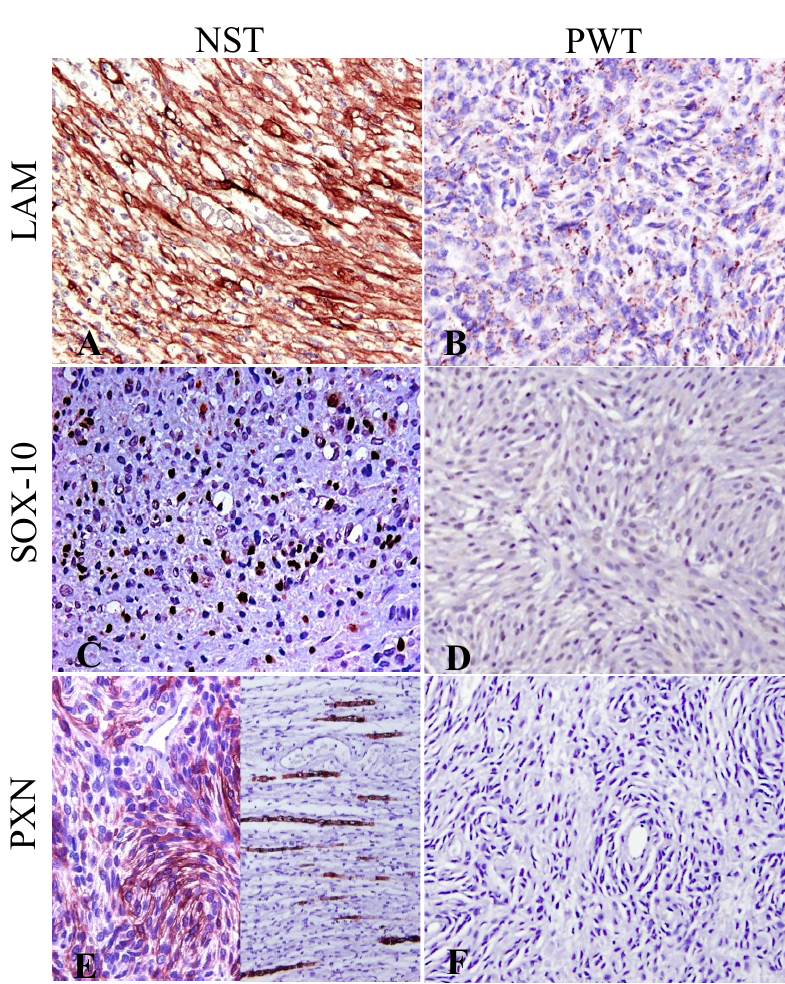
Figure 4. Discriminatory IHC panel between NST and PWT. The selected PNS panel including laminin (LAM), Sox-10 and periaxin-1 (PXN) was compared between NST and PWT. Laminin was detected in all tumors but the LAM immunolabeling pattern of PWT was different than in NST ( A , B ). NST retained Sox-10 and PXN immunoreactivity, whereas PWT did not ( C , D ). Note that PXN immunoreactivity can be observed in the cytoplasm of neoplastic cells ( E , left) and/or in nerve sheaths retained within the tumor ( E , right) in NST, but no PXN was detected in PWT ( E , F ). All NST tumors, except one neurofibroma (Case 9), displayed similar indices or percentages of Ki-67+ proliferating cells and of PHH3+ mitotic cells (Table 2).